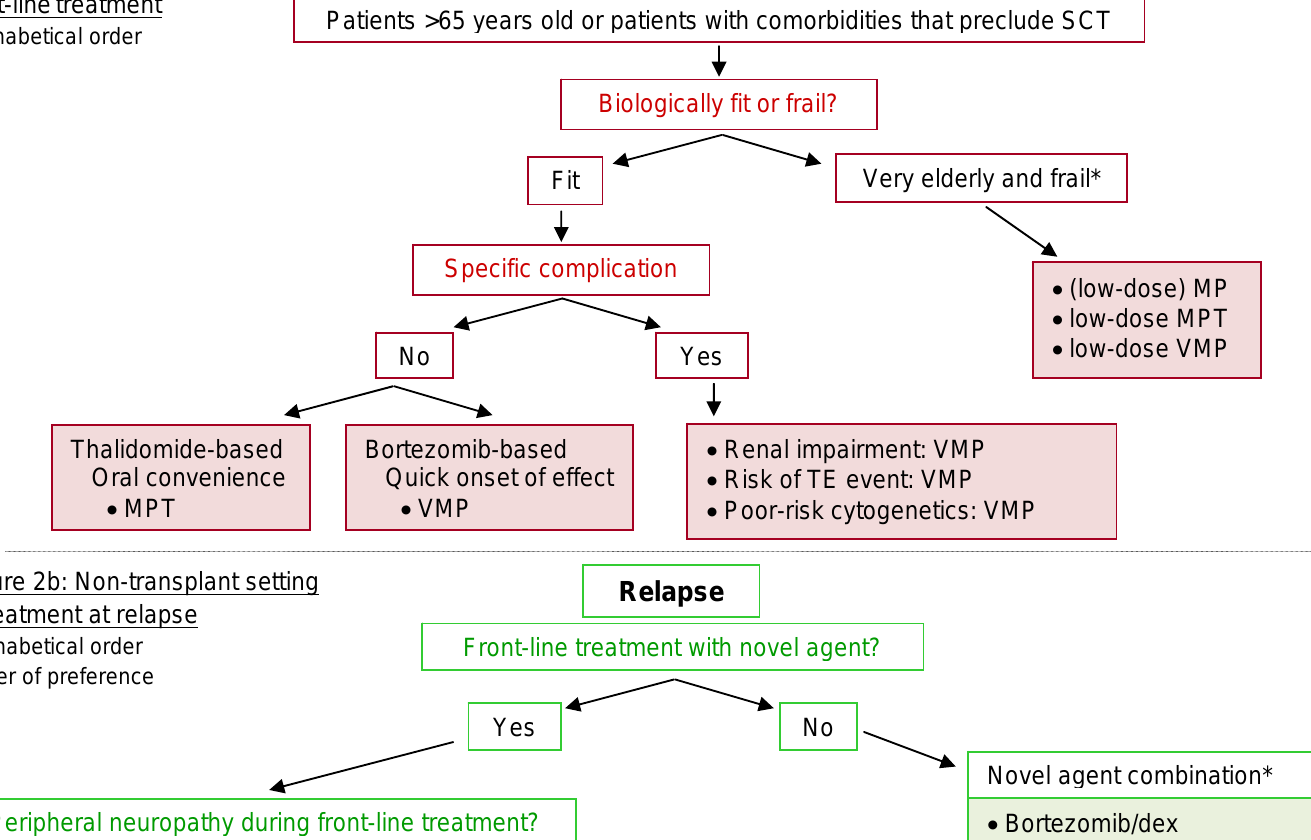
Figure 2b: Non-transplant setting – treatment at relapse *alphabetical order † order of preference